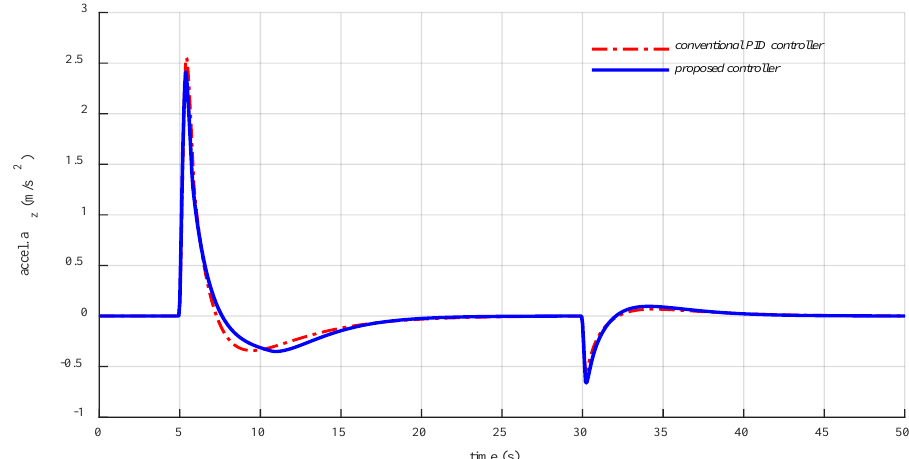
Figure 10. Comparison of the vertical acceleration performance between our new controller and a conventional PID controller for Scenario 1.